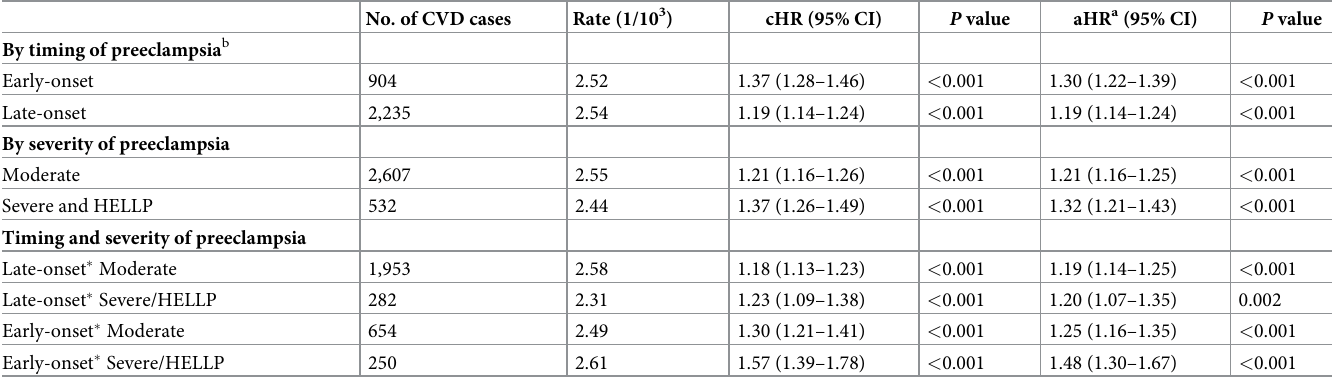
Table 4. The risk of early-onset CVD in offspring according to the timing and severity of maternal